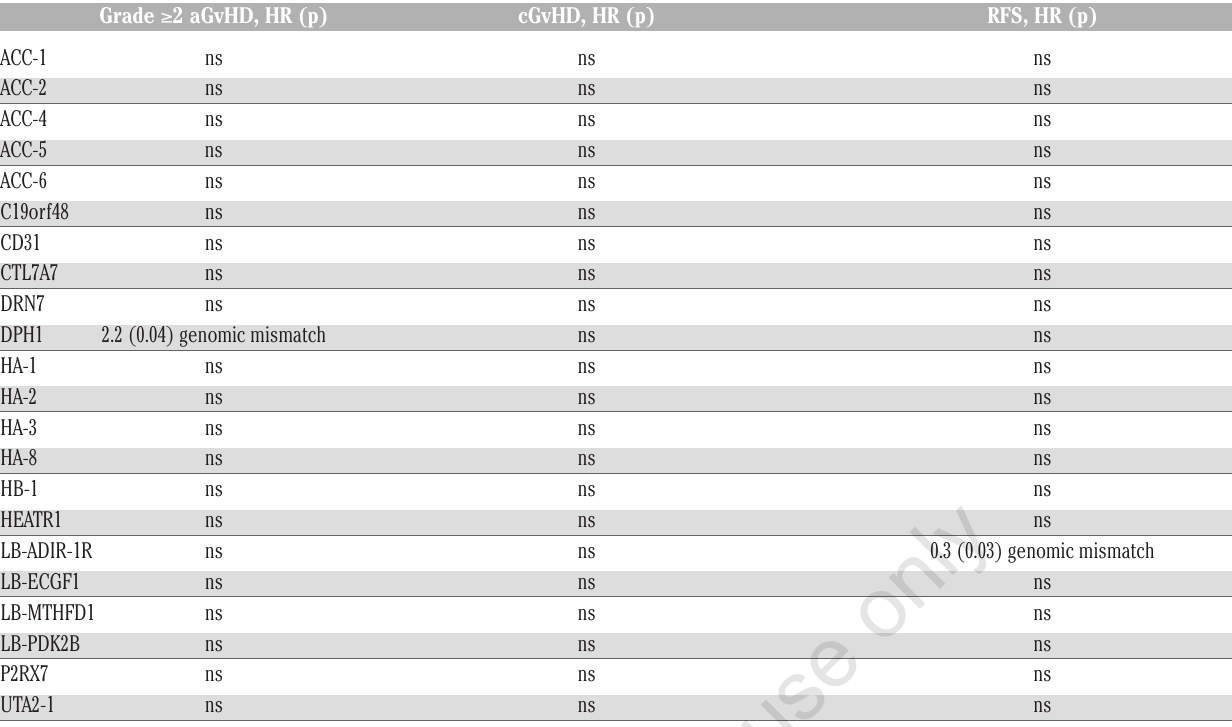
Table 5. Multivariate analysis of relationship btween mHAgs and aGvHD, cGvHD or RFS. Grade ≥ 2 aGvHD, HR (p) cGvHD, HR